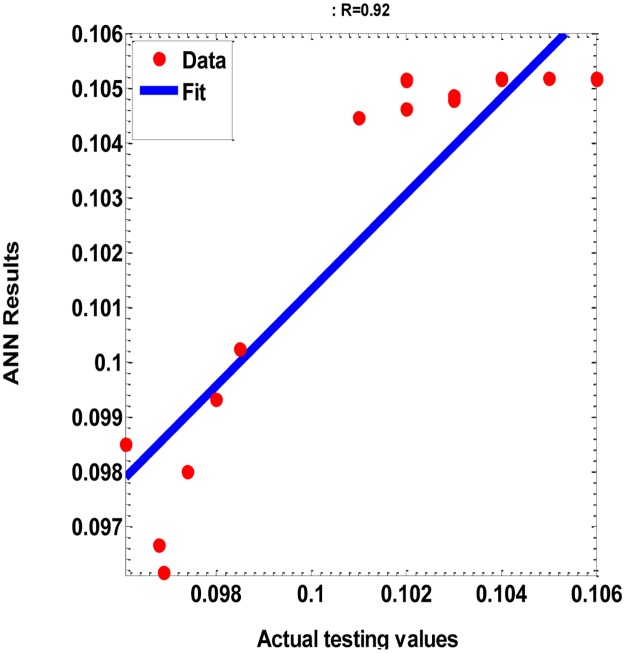
scatter plot of the testing data with the corresponding of the ANN’ model results, with (R = 0.92, and SSE = 7.19E-05).